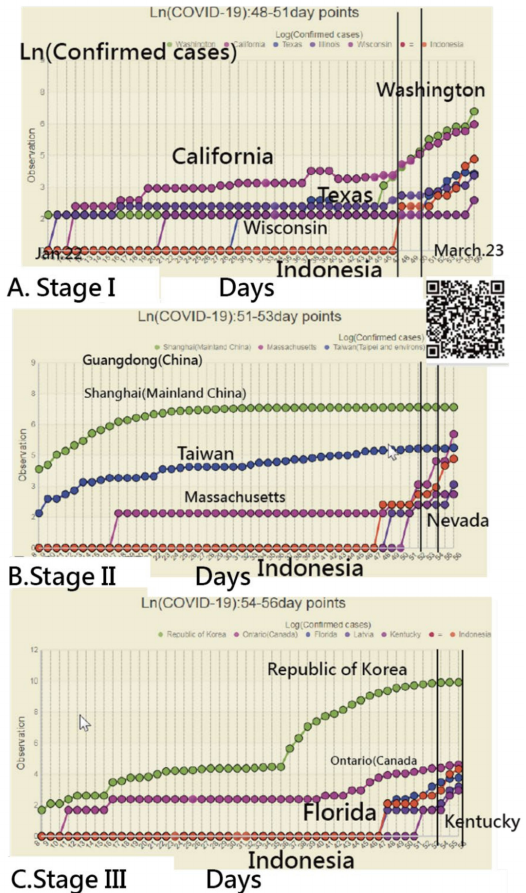
Figure 4. Using the example of Indonesia to interpret the similarities between regions across three stages (Note: readers are invited to scan the QR-code to examine the detail on a